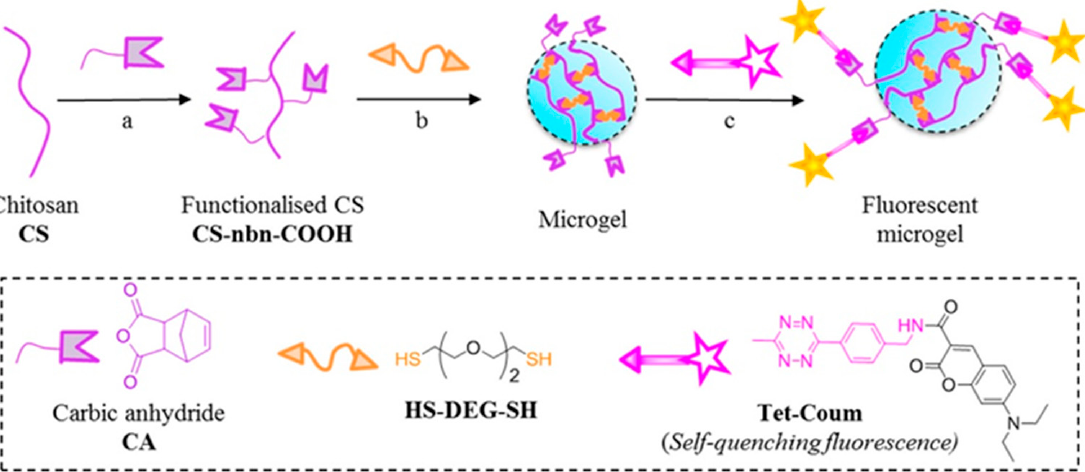
Figure 9. Synthesis of norbornene-derived chitosan-based microgels, reprinted with permission from [38]. Copyright 2019 American Chemical Society.